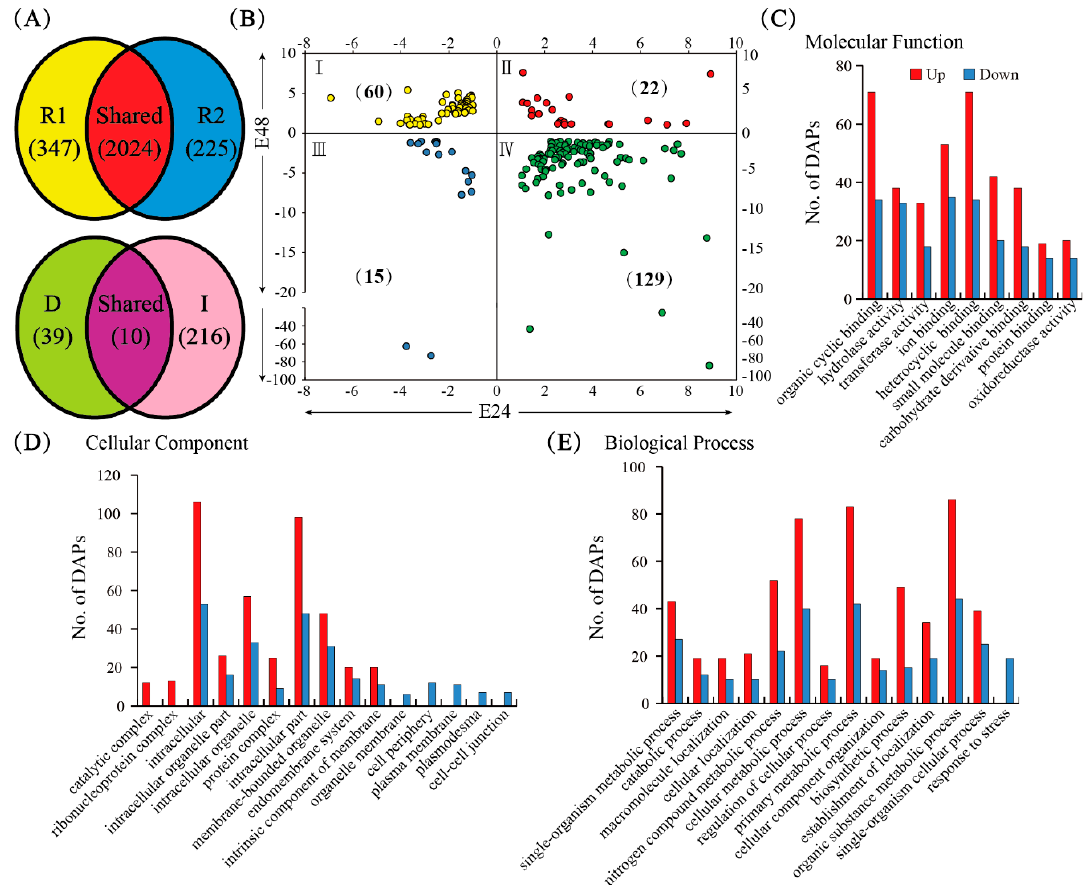
Figure 4. Isobaric tags for relative and absolute quantification (iTRAQ) analysis of SRPs proteins upon ethylene stimulation. The Venn diagram demonstrates that 2024 unique proteins were shared in the two iTRAQ experiments ( A ). A total of 226 DAPs were determined from iTRAQ, and 49 unique proteins from 2-D DIGE, which resulted in 10 shared unique proteins ( A ). The DAPs from iTRAQ were classified into four areas based on their changed patterns in different SRPs ( B ). The statistical protein numbers of the 265 DAPs involved in molecular function ( C ), the cellular components, ( D ) and biological process ( E ) are highlighted.